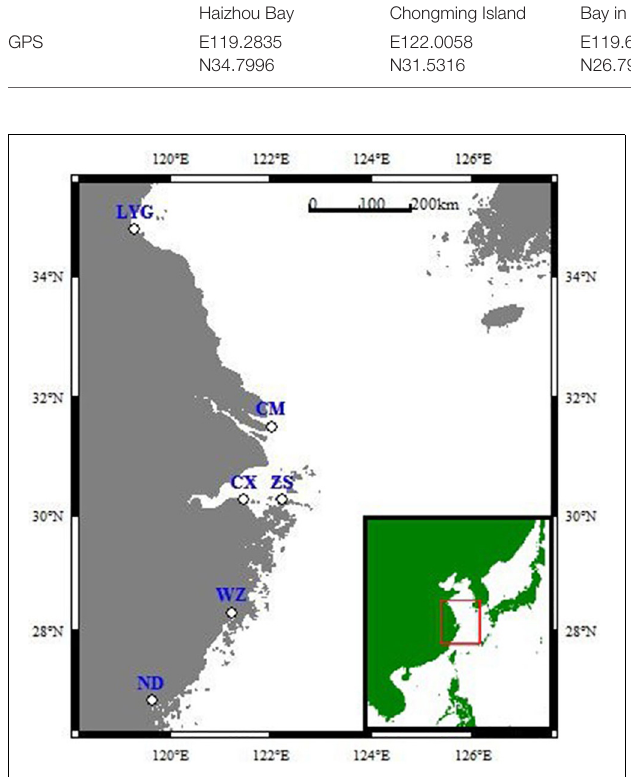
FIGURE 1 | Sample collection map of rainbow clams in coastal